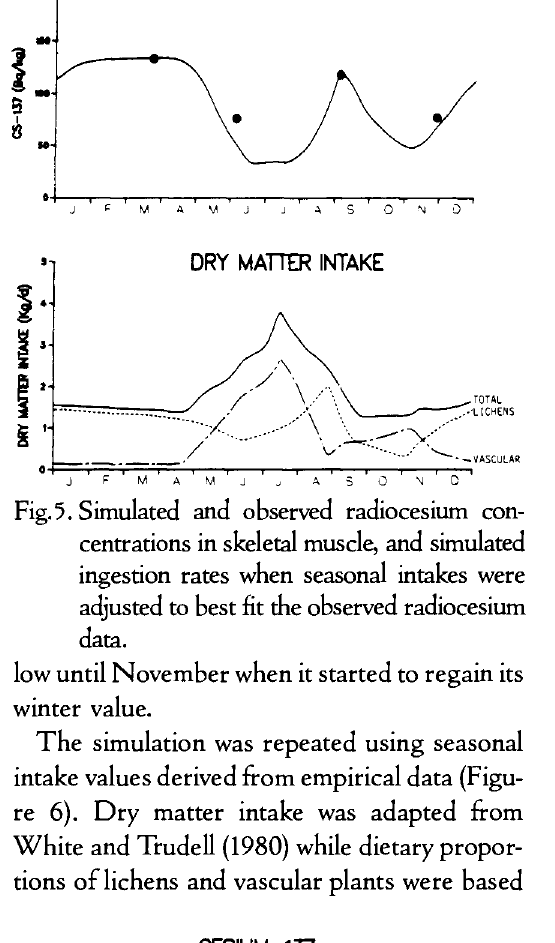
Fig.7. Simulated and observed radiocesium con centrations in skeletal muscle, and simulated ingestion rates when seasonal intakes were adjusted to yield a "conventional" cesium